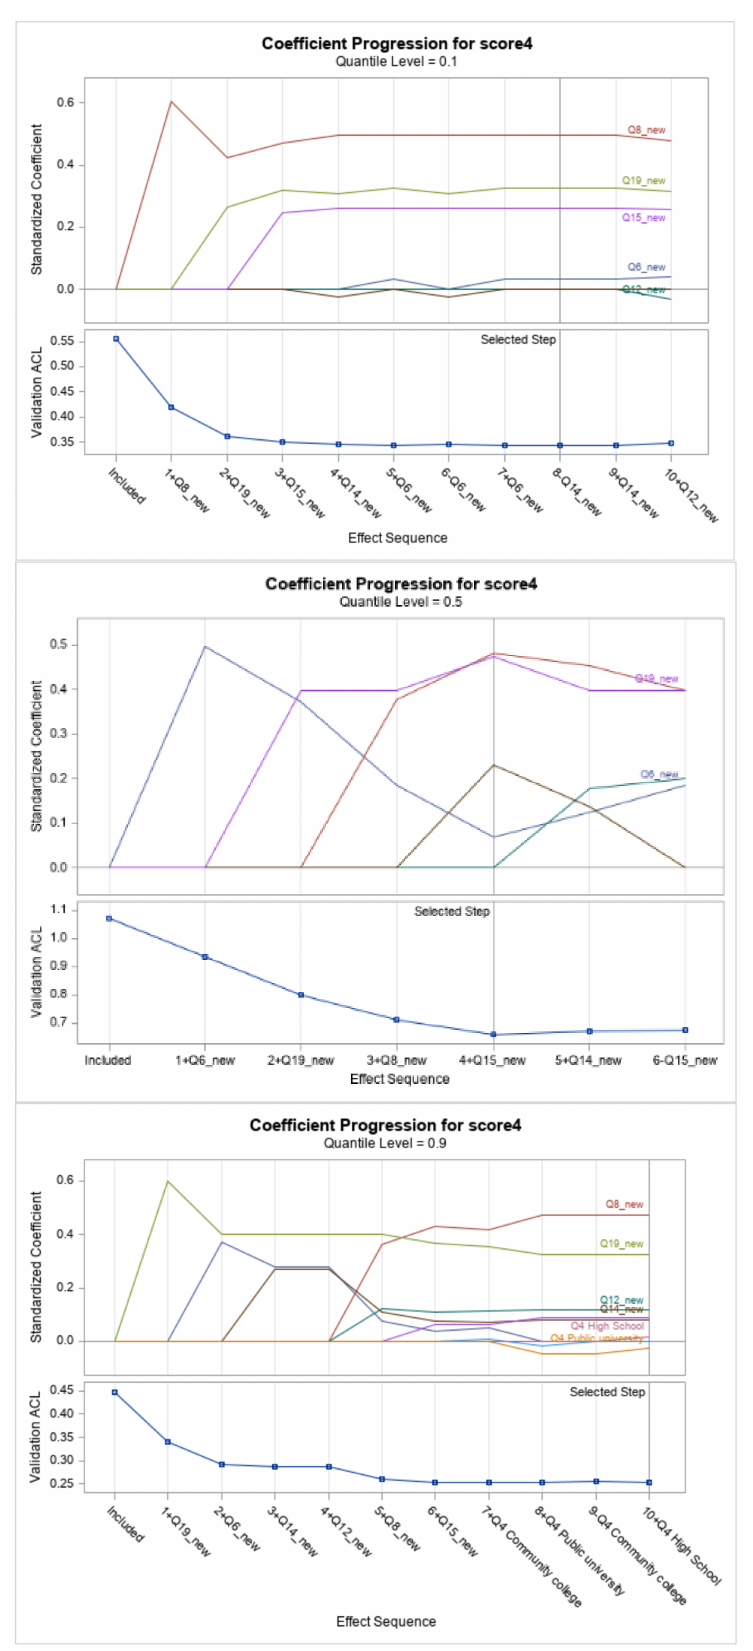
Figure 5. Plots of coefficient progression plots for Score 4 at 0.1, 0.5, and 0.90